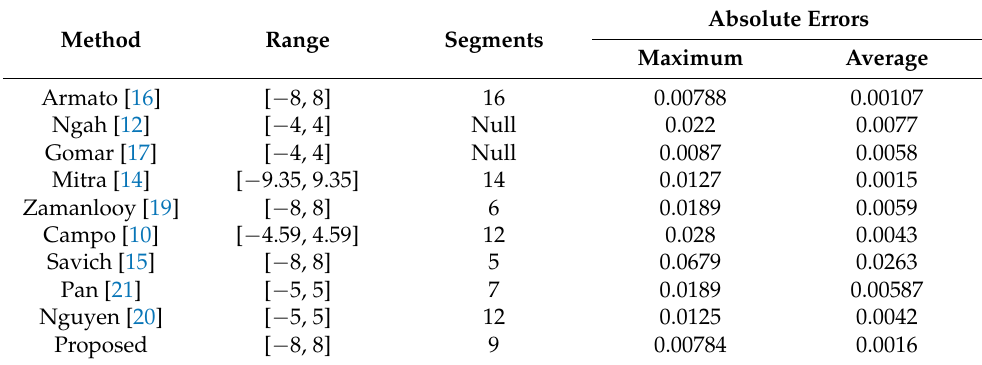
Table 6. Absolute errors of different fitting methods for the sigmoid